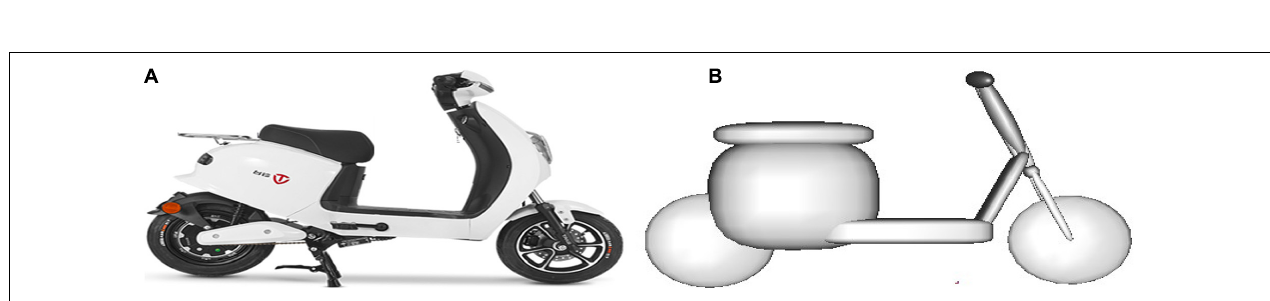
Frontiers in Bioengineering and Biotechnology |